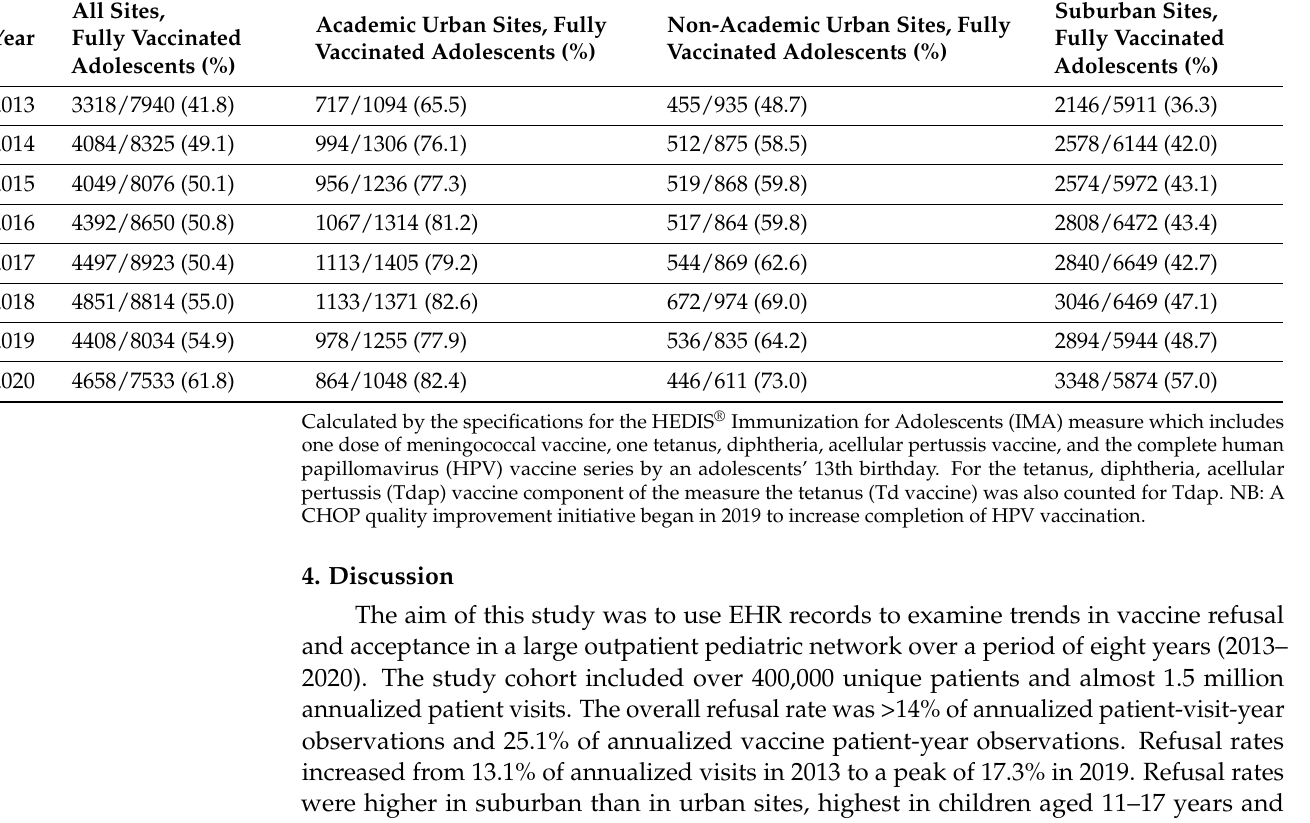
Table 6. Vaccination Coverage of Routinely Recommended Advisory Committee on Immunization Practices Recommended Adolescent Vaccines in the Children’s Hospital of Philadelphia Primary Care Outpatient Network,